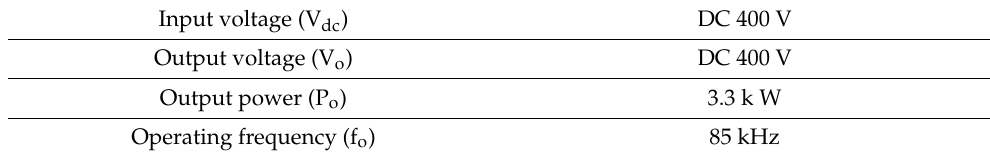
Table 1. Experimental conditions of wireless power transmission system.